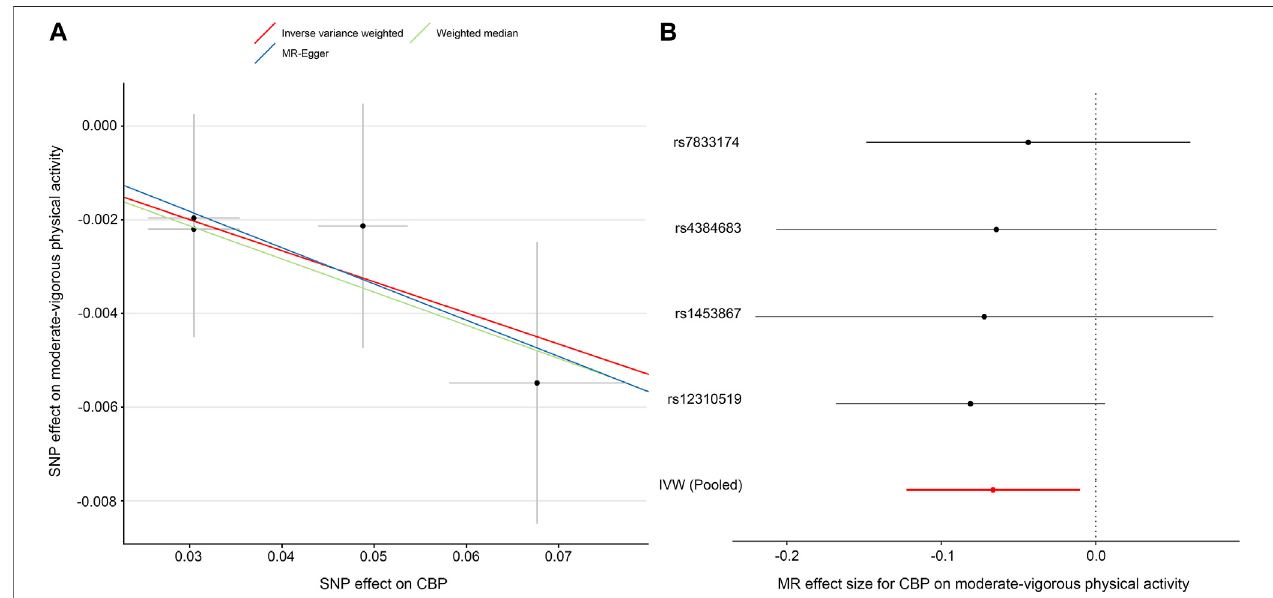
FIGURE 3 | MR plots for the effect of chronic back pain (CBP) on moderate-vigorous physical activity. (A) Scatter plot of the SNP effect on CBP vs. that on moderate-vigorousphysicalactivity.Theslopeofeach fi ttedlinerepresentsthepooledMReffectcalculatedbyeachmethod. (B) ForestplotofindividualandpooledMR effectsizesforCBPonmoderate-vigorousphysicalactivity.Eachpointanditscorrespondinglinerepresentthe β valueandits95%CI,respectively.Abbreviations:SNP, single-nucleotide polymorphism; CBP, chronic back pain; MR, Mendelian randomization; IVW, inverse variance weighted.